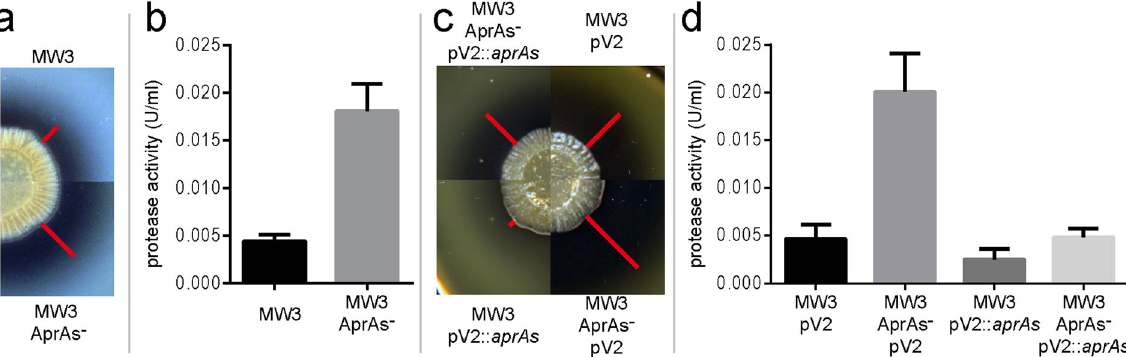
Figure 3. Determination of exoprotease activity by qualitative and quantitative measurement in B . licheniformis MW3 and mutant strains. For qualitative determination of exoprotease activity ( a , c ), cultures were adjusted to OD 600 of 0.1. Of each culture 3 µ l were dropped on a M9 skim milk agar plate and incubated for 5 days at 37 °C. Exoprotease activity led to the digestion of milk protein resulting in a surrounding halo. The size of the respective halos is indicated with a red bar. For quantitative determination of exoprotease activity ( b , d ), all cultures were inoculated to an OD 600 of 0,1 in liquid M9 skim milk medium and incubated for 24 h under intensive shaking. The exoprotease activity was determined using the culture supernatant. ( a ) B . licheniformis MW3 AprAs − reveals an increased exoprotease activity visible through a stronger halo formation compared to MW3. ( b ) The four fold increased exoprotease activity of B . licheniformis MW3 AprAs − confirms the exoprotease phenotype observed in Fig. 3a. ( c ) B . licheniformis MW3 pV2:: aprAs shows the smallest halo formation. The halo of the complemented B . licheniformis MW3 AprAs − pV2:: aprAs is comparable to MW3 pV2. B . licheniformis MW3 AprAs − pV2 shows the strongest proteolytic activity indicated by the largest halo formation. The ectopic transcription of aprAs results in a reduction of exoprotease activity in both MW3 and mutant AprAs − . ( d ) The protease activity of the complemented strain B . licheniformis MW3 AprAs − pV2:: aprAs is strongly decreased compared to B . licheniformis MW3 AprAs − and comparable to B . licheniformis MW3 pV2. B . licheniformis MW3 pV2:: aprAs shows an approximately 50% reduced exoprotease